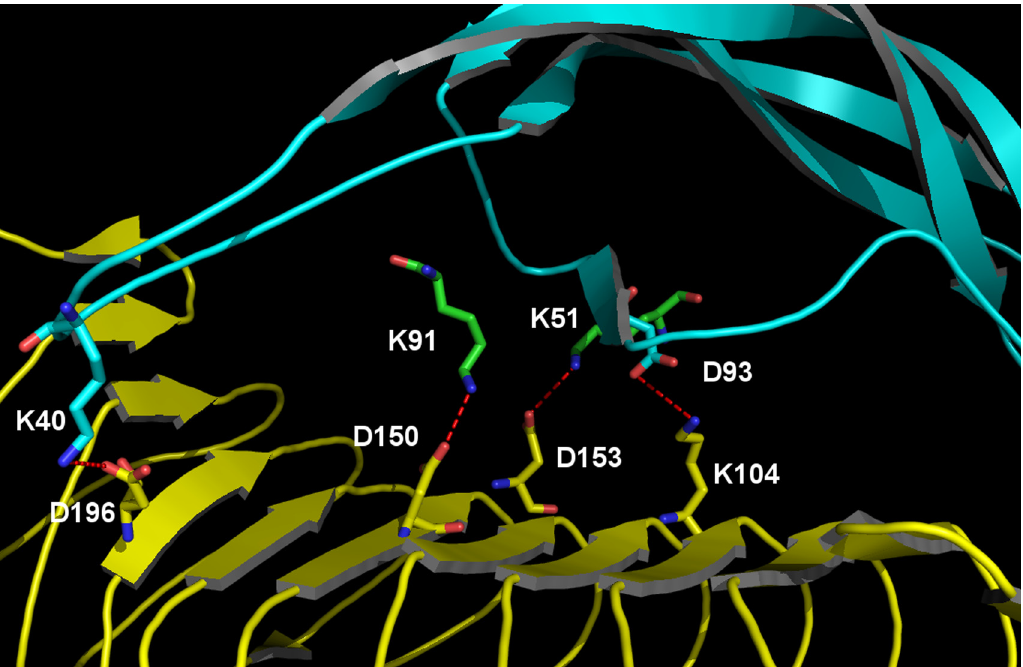
Fig 11. Key FSH/FSHR interface salt bridges underlying the electrostatic distinctions between FSH 15 (TAG) and FSH 24 (TAG). FSH is depicted as cyan ribbons with key residues shown as green/CPK-colored sticks, whereas FSHR is rendered via yellow ribbons and yellow/CPK-colored sticks.